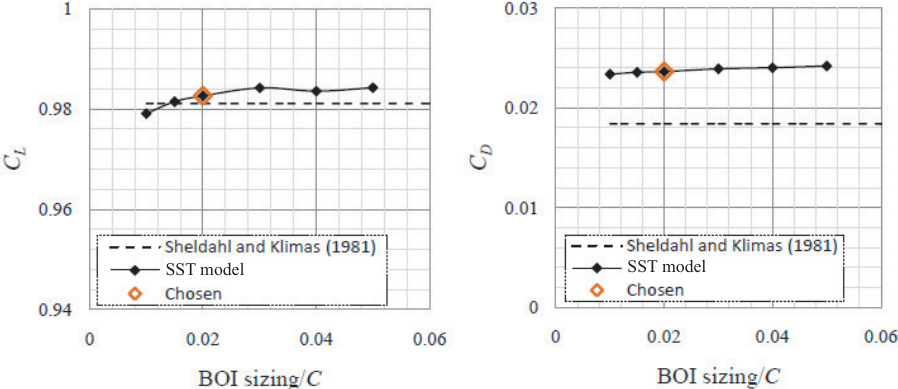
Figure 14. Variation in lift and drag as a function of second body of influence sizing with radius of 2 C ( α = 10 ◦ , Re = 3.6 × 10 5